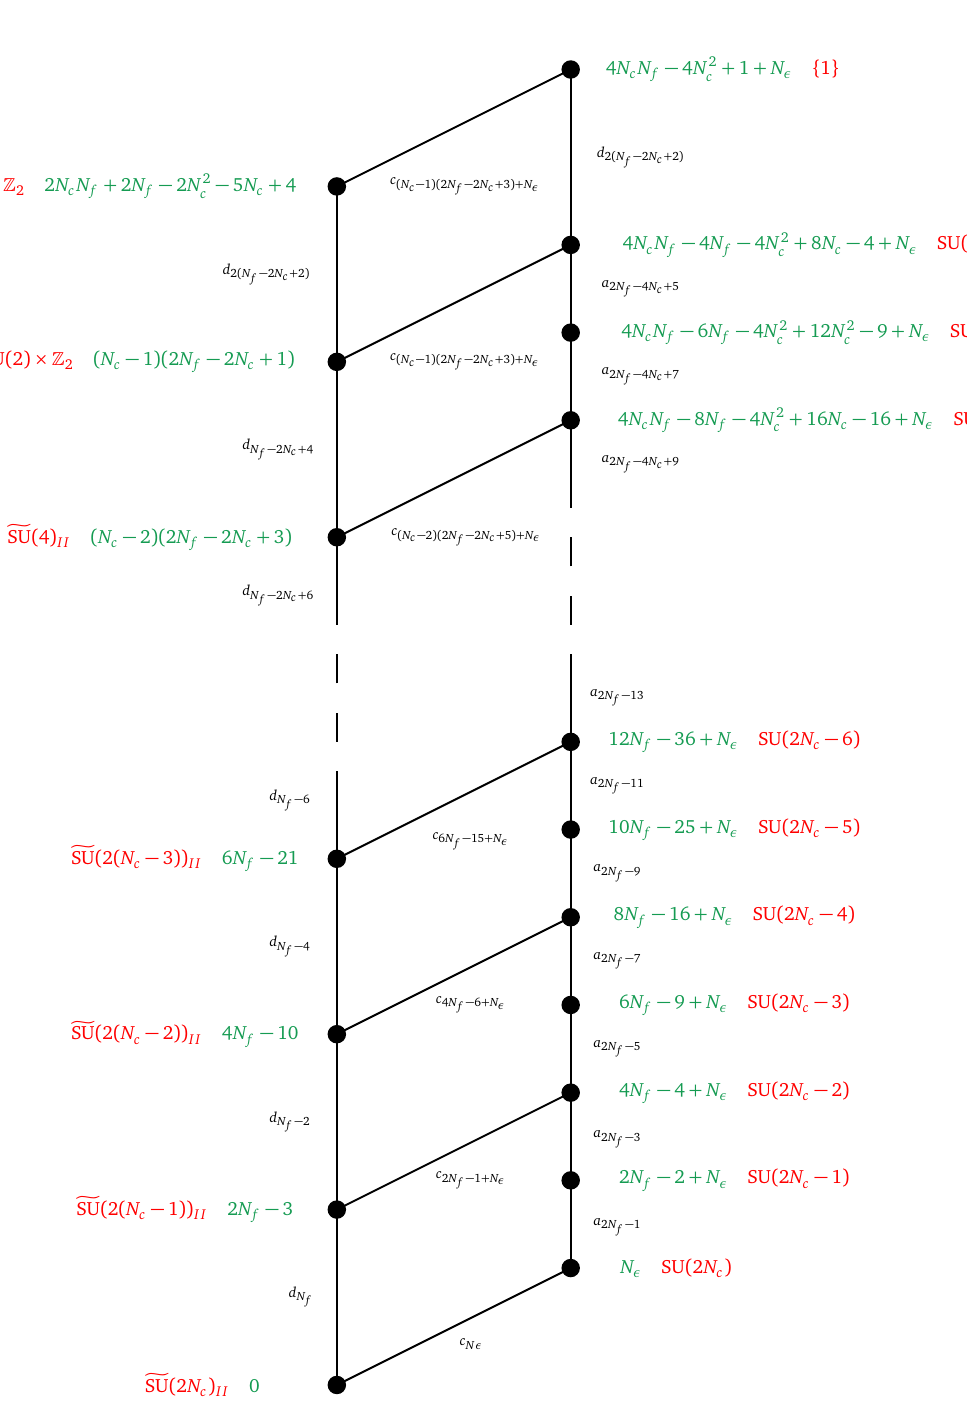
Figure 5: Higgs branch Hasse diagram of (cid:221) SU ( 2 N The green numbers are the quaternionic dimensions of the leaves, and the red groups are the residual gauge